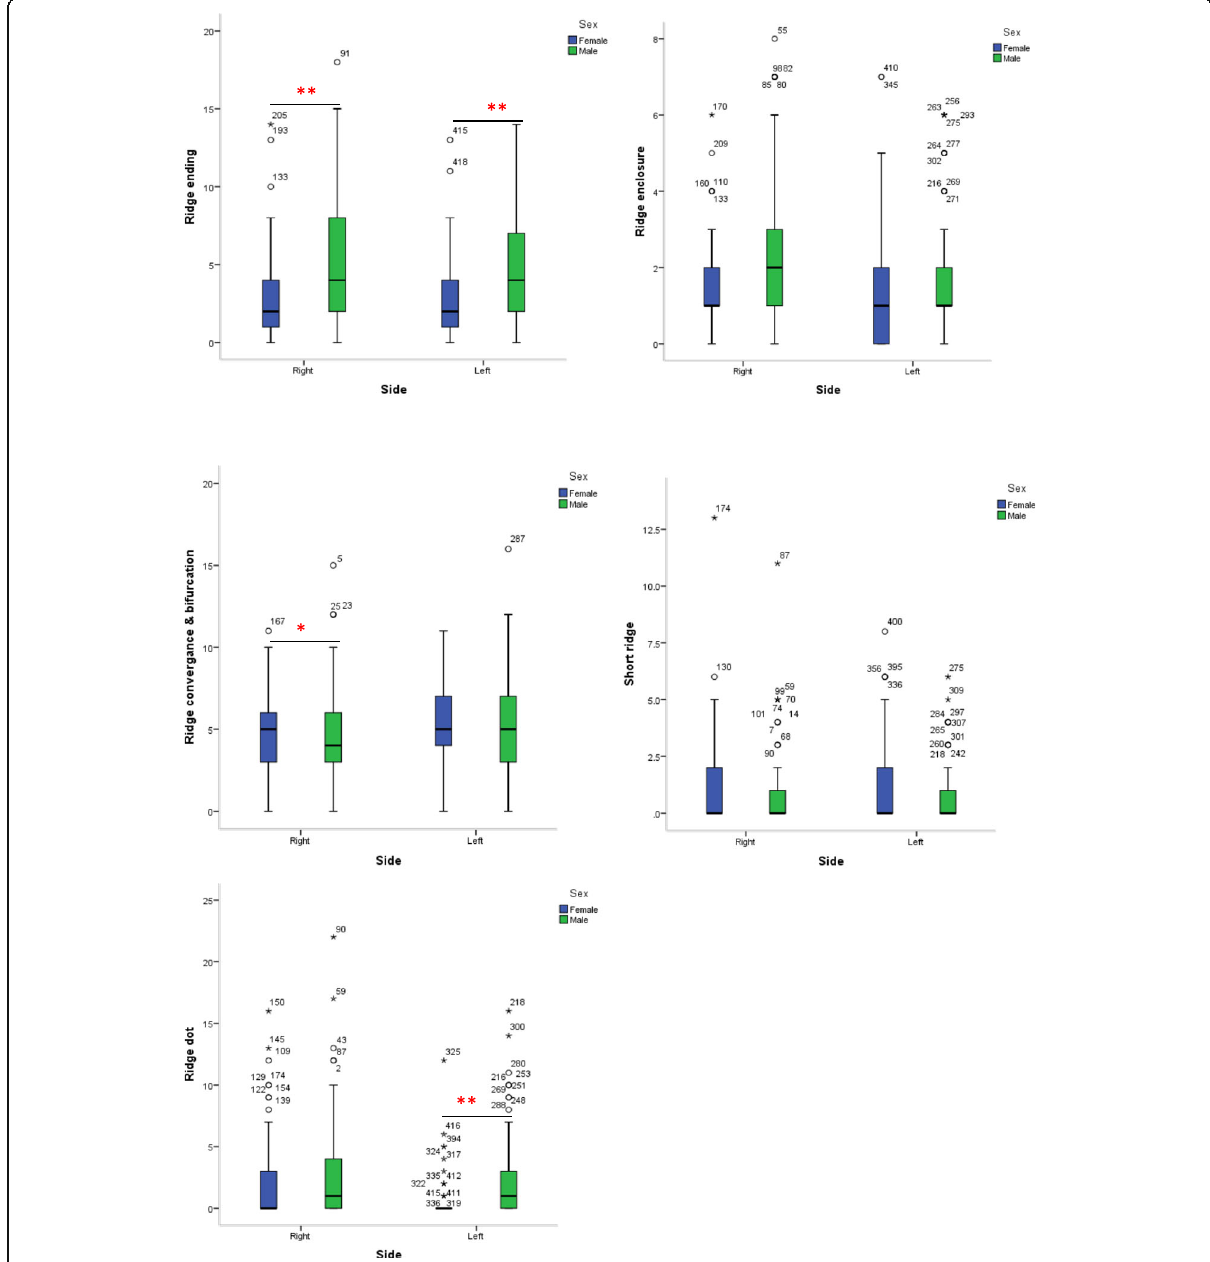
Fig. 2 Sex differences in five different types of minutiae (ridge ending, enclosure, convergence & bifurcation, short and dot) of study population. The data were analyzed using Mann Whitney test. Mid-point ( black ) of the box represents the median; the bottom of the box indicates 25th percentile (2nd quartile) and top of the box 75th percentile (3rd quartile). The lower and upper limit of the whiskers (T-bars at the bottom and top of the box ) represents the minimum to maximum. The dot/asterisk ( black ) indicates outliers [values that do not fall in the whiskers (1.5 times the height of the box )] and the numbers indicate the serial number of the outliers in the data series ** P <0.01, * P